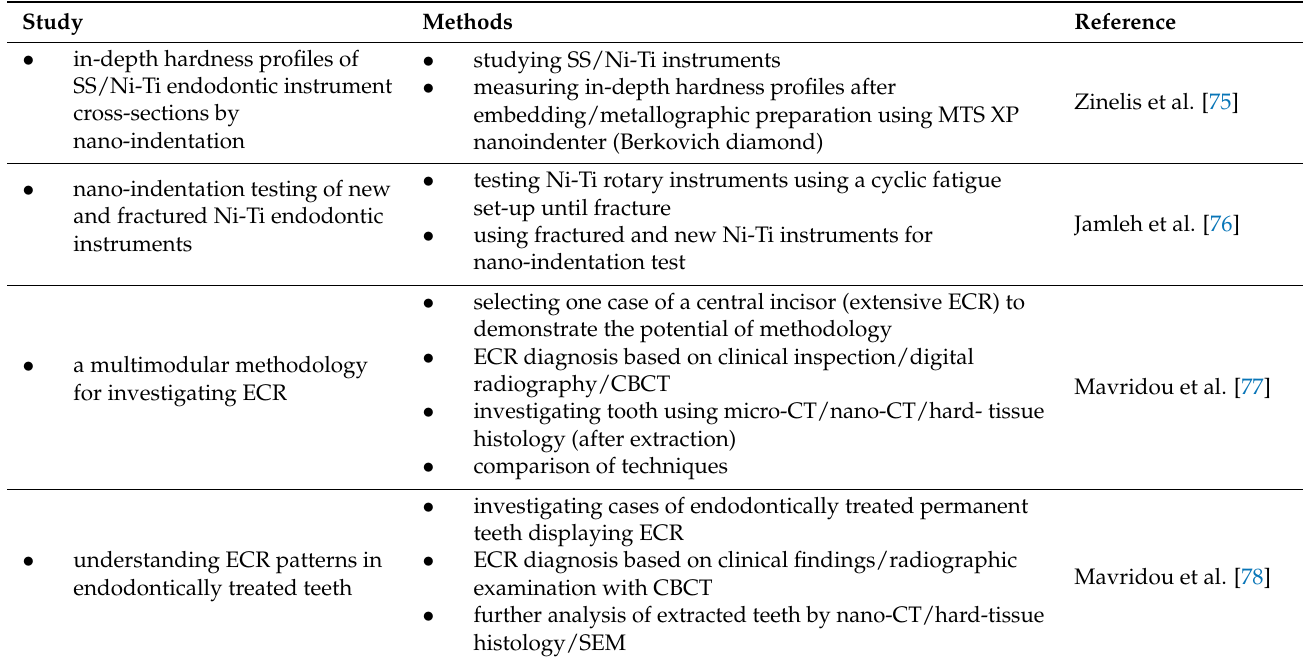
Table 3. Nanotechnology applications in endodontics: nano-testing of